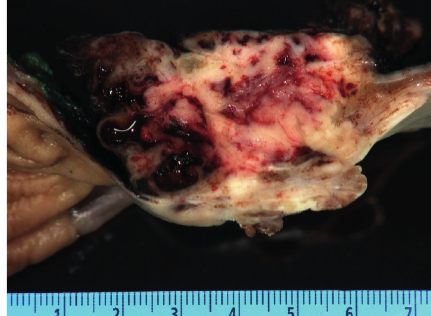
Figure 2: Cross-section of the fixed mass within the esophagus demonstrating the blood spaces and that the lesion is centered on the muscularis propria.